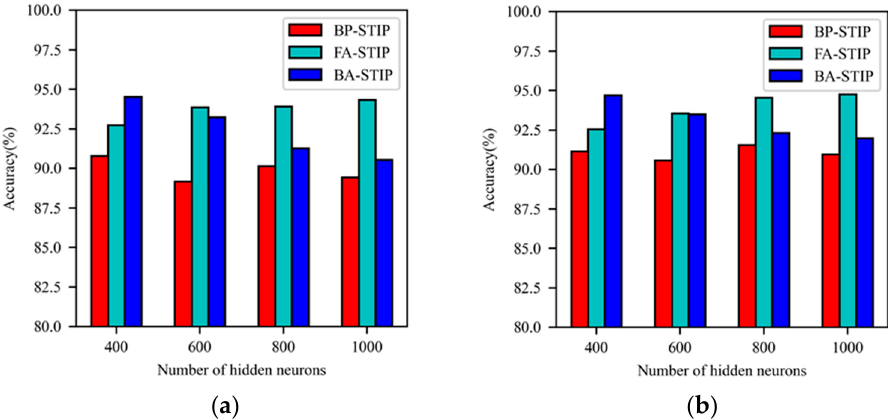
Figure 6. Comparison of learning performance for three STIP-based algorithms with Laplacian kernel function. ( a ) The accuracy of the training set; ( b ) the accuracy of the testing set.